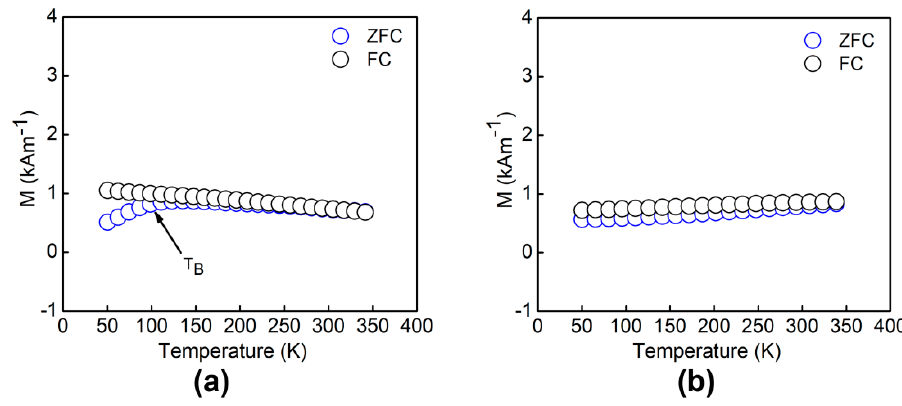
Figure 9. ZFC and FC curves: ( a ) LTO:Fe-HC and ( b ) LTO:Fe-LC.